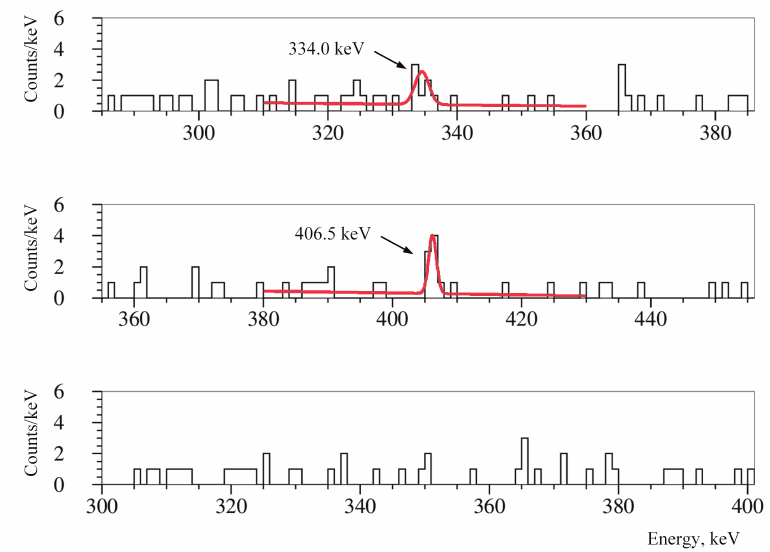
Figure 4. Coincidence energy spectra measured by the GeMulti setup with the 2.381 kg Nd 2 O 3 sample over 16,375 h when the energy in one detector was fixed to the energy interval at which γ s from the 150 Nd → 150 Sm (0 + , 740.5 keV) decay—406.5 keV ± 1.4 × FWHM (top), 334.0 keV ± 1.4 × FWHM 1 (middle)—are expected. The bottom spectrum shows a random coincidence background in the energy range of interest when the energy of events in one of the detectors is taken as 375 keV ± 1.4 × FWHM (no γ s with this energy are expected in either the 150 Nd 2 β decay nor in the decays of nuclides that are radioactive contaminants of the Nd 2 O 3 sample or of the